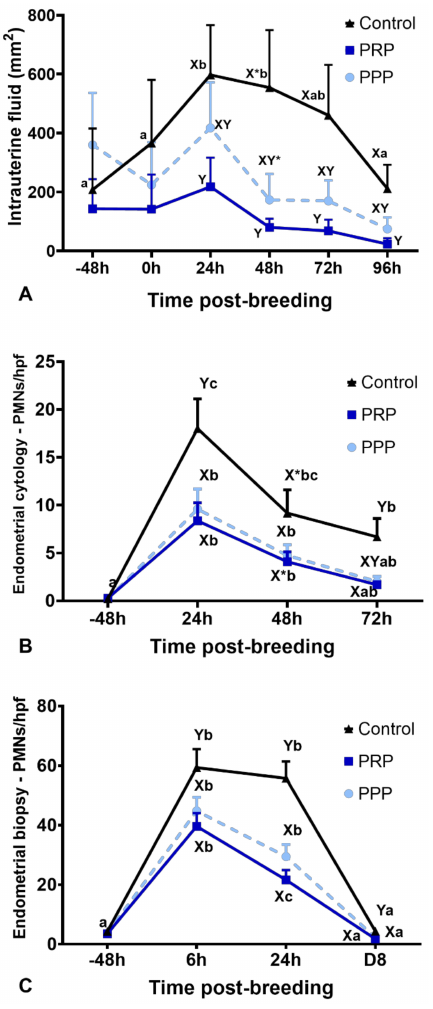
Figure 2. Post-breeding inflammatory response in mares susceptible to persistent breeding induced endometritis. Assessments were carried out from pre- (early onset of estrus) and post-breeding, and on the day of embryo flushing (eight days post-ovulation, D8): ( A ) Intrauterine fluid accumulation pre- and post-breeding; ( B ) mean polymorphonuclear cells (PMNs) assessed in five high-power fields (hpf) in endometrial cytology, and ( C ) mean PMNs counts assessed in five hpf in endometrial biopsies. Mares ( n = 12) had estrous cycles ( n = 34) assigned to receive four intrauterine infusions with Lactate Ringer’s Solution (Control, n = 12), platelet-rich (PRP n = 12), or -poor plasma (PPP n = 10) in a crossover design. Different superscripts denote the effects of time ( a,b,c ) and differences between groups ( X,Y ) ( p < 0.05). Asterisk (*) denotes tendency (0.05 < p <